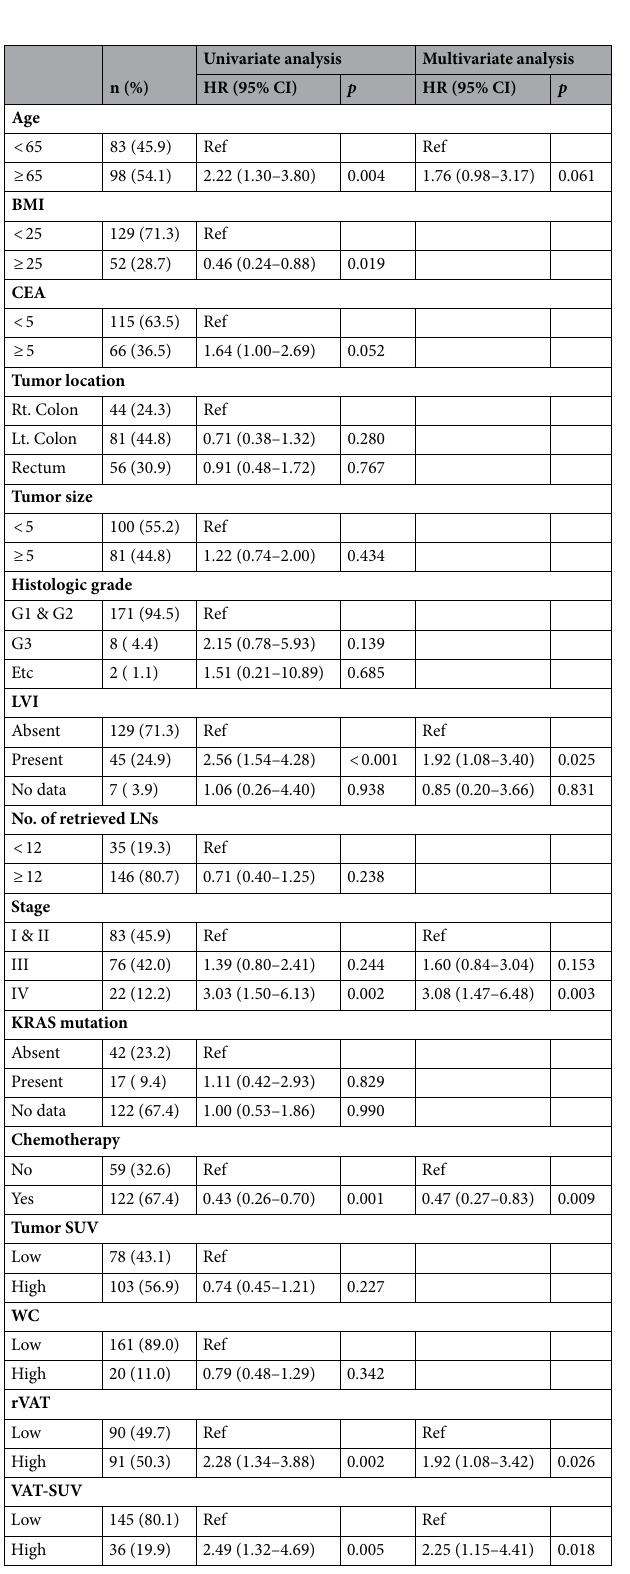
Table 2. Univariate and multivariate analyses associated with the overall survival in males (n = 181). ASA = American society of anesthesiology, BMI = Body mass index, CEA = Carcinoembryonic